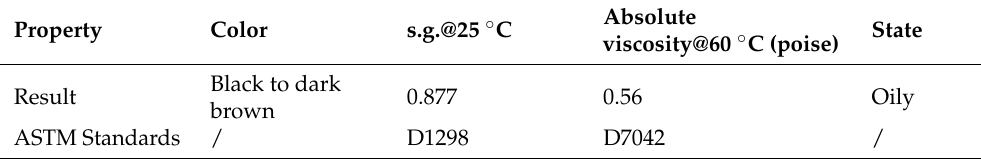
Table 9. Physical characteristics of WEO.